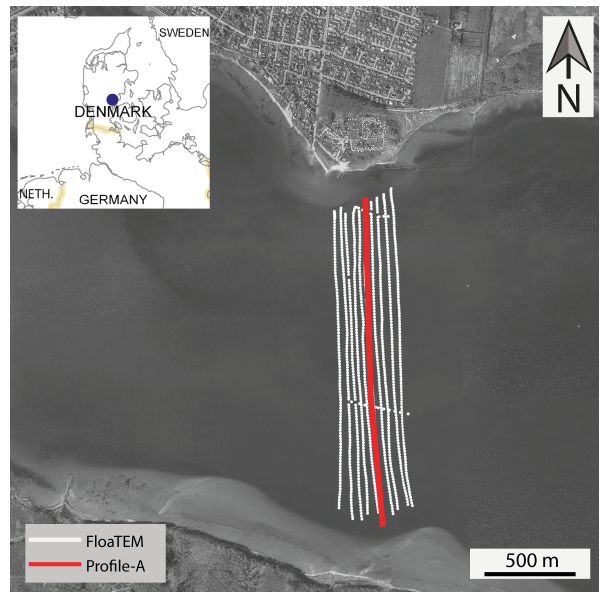
Figure 8. Horsens bay with FloaTEM survey lines. The red high- lighted profile marks the location of the resistivity section shown in Fig.